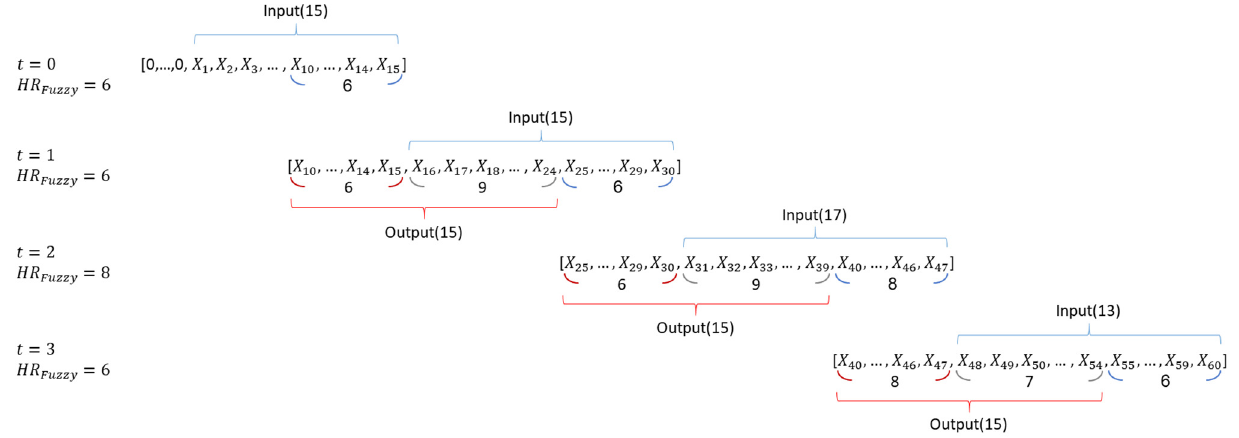
Figure 11. A sequence diagram of the heart rate vector.